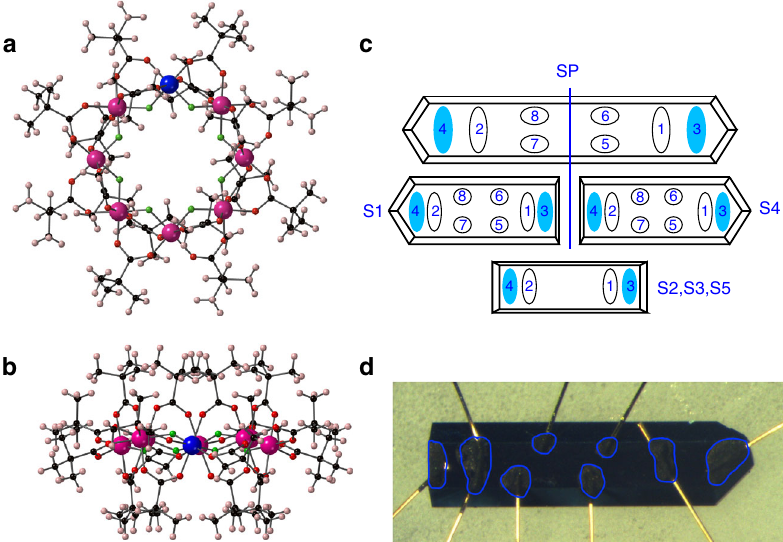
Fig. 1 Surface modi fi cations and sample con fi gurations. a , b The structure of the metallic-ring molecules used to modify the TI surface state, viewed a perpendicular to the ring and b parallel to the ring. The core of eight transition metal ions (blue and magenta) in a ring geometry is stabilised by organic ligand groups to form [M 7 ZnF 8 (O 2 C t Bu) 16 ] − (Me 2 NH 2 ) + . The (Me 2 NH 2 ) + counterion is not shown. With M = Cr, the molecule is magnetic with a ground state spin of S = 3/2; M = Ga is perfectly diamagnetic. The non-conjugated organic ligands surround the metallic core in all directions, isolating the core from the surface onto which the molecule is sublimed. This ensures that the interaction between the metallic core and the surface is perturbative. c Schematic sketches of the sample and contact geometries used ( fi lled blue ovals: current contacts; open ovals: voltage contacts). S1 and S4 were obtained by carefully breaking SP in half, and are mounted with contacts permitting measurements of both longitudinal and transverse resistance components. After characterising their pristine electrical transport characteristics, S1 was decorated with Cr 7 Zn and S4 was decorated with Ga 7 Zn. To check the reproducibility of the effects of our surface modi fi cation, we performed longitudinal resistance measurements on three further samples, S2, S3, and S5. After measurements of the pristine samples, S2 and S3 were decorated with Cr 7 Zn and S5 was decorated with Ga 7 Zn. d A photograph of S1 showing the hand-applied carbon-paste contacts and 25 μ m gold wires. The contacts are outlined in blue for